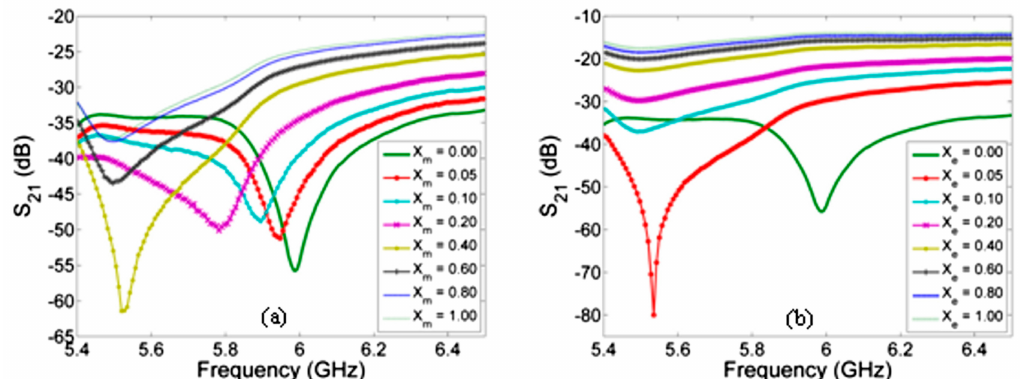
Figure 13. Transmittance changes for different content of methanol ( a ) and ethanol ( b ) in the deionized water in the tested solutions [49]. Reprinted from Song, C.; Wang, P. A radio frequency device for measurement of minute dielectric property changes in microfluidic channels. Appl. Phys. Lett. 2009 , 94 , 1–4, doi:10.1063/1.3072806 with permission from AIP Publishing.